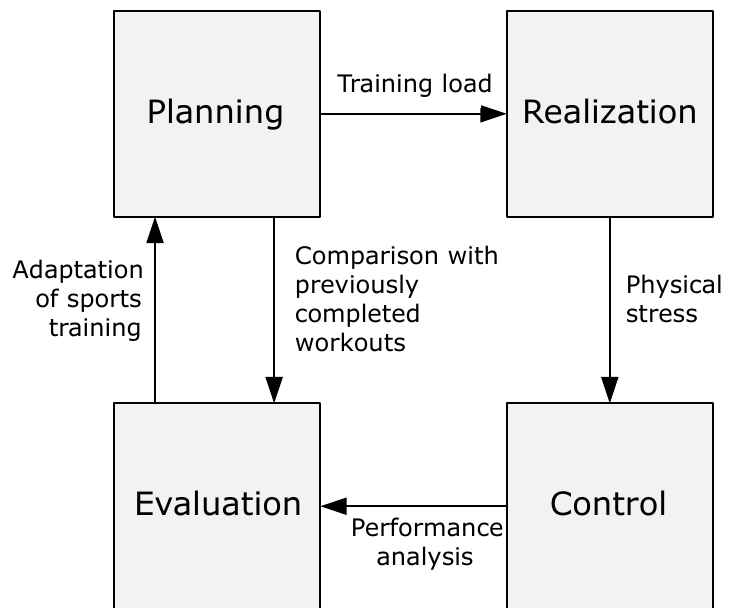
Figure 1. The four phases of sport